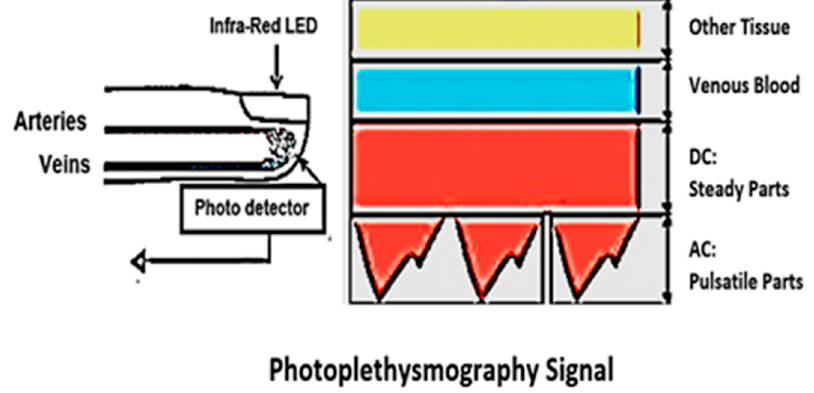
Figure 1. Direct current and alternating current components of the PPG signal due to variation in light absorption.